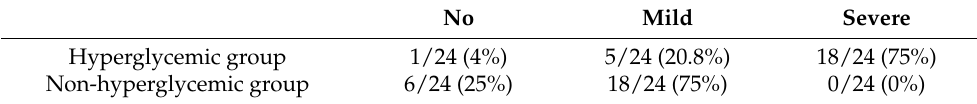
Figure 4. Changes in the area of islets of Langerhans in the pancreas: ( A ) changes in the area of islets of Langerhans in hyperglycemic group and non-hyperglycemic group over time. * p < 0.05. ( B ) Severity of morphological changes of islet of Langerhans and blood glucose level over time. ** p < 0.01. ( C ) Correlation between morphological abnormalities of islet of Langerhans and liver tumor incidence. ** p < 0.01. Table 3. Frequency of the damage of islets of Langerhans in TSOD mice in experiment 1.